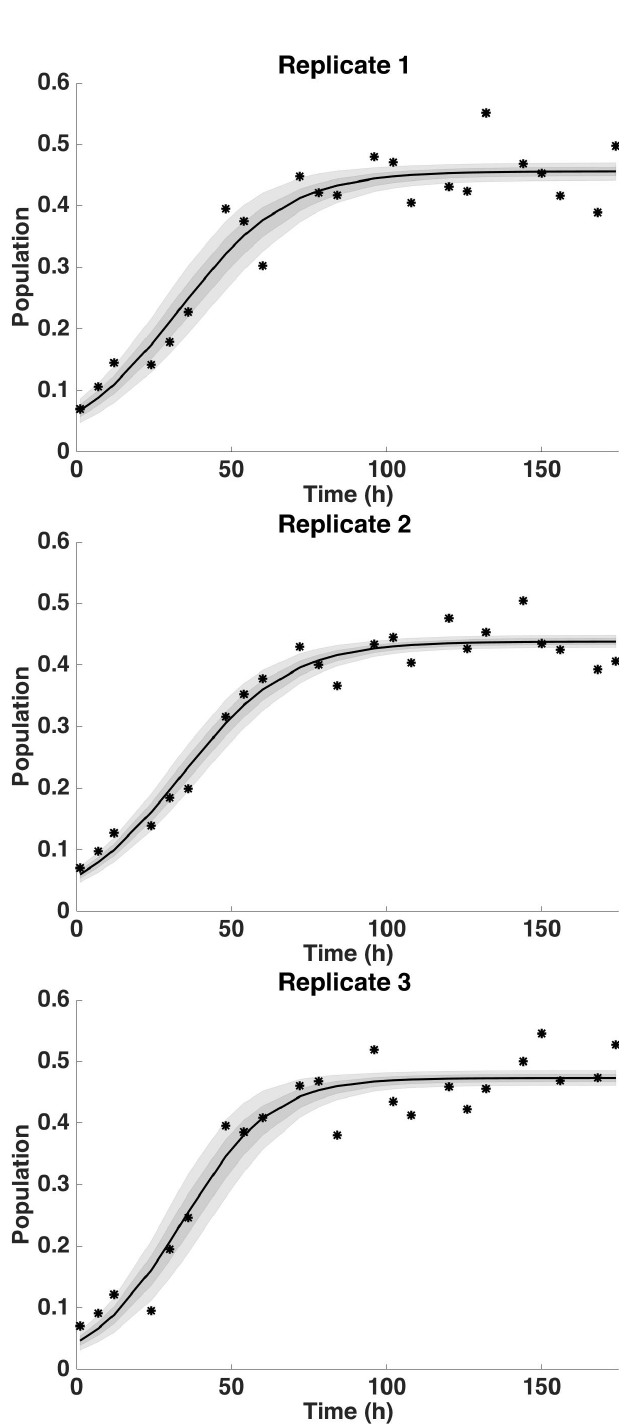
Figure 2. Plots of forward solutions for the discrete Euler-method logistic (DEL) please confirm. model for the three replicates of the data from left to right. Replicate one is on top and three is on the bottom. The lighter and darker shades of grey represent the 95% and 68% confidence bars on the model solution, respectively. The algae population is represented as cells × 10 7 /L. Data points are shown as